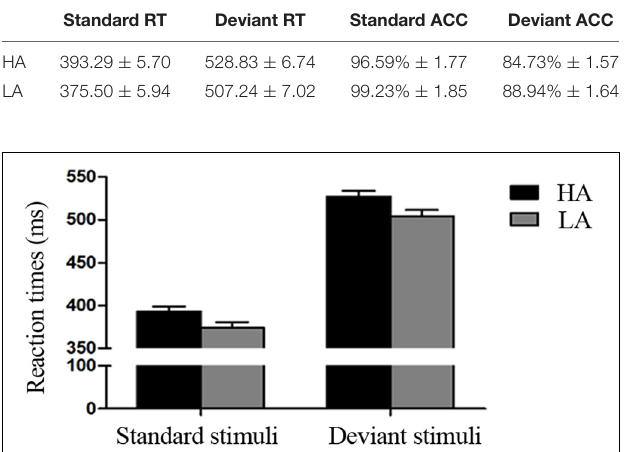
TABLE 1 | Averaged reaction times (RTs) and accuracy values for standard and deviant conditions for low-altitude (LA) and high-altitude (HA) groups ( M ± SD ).